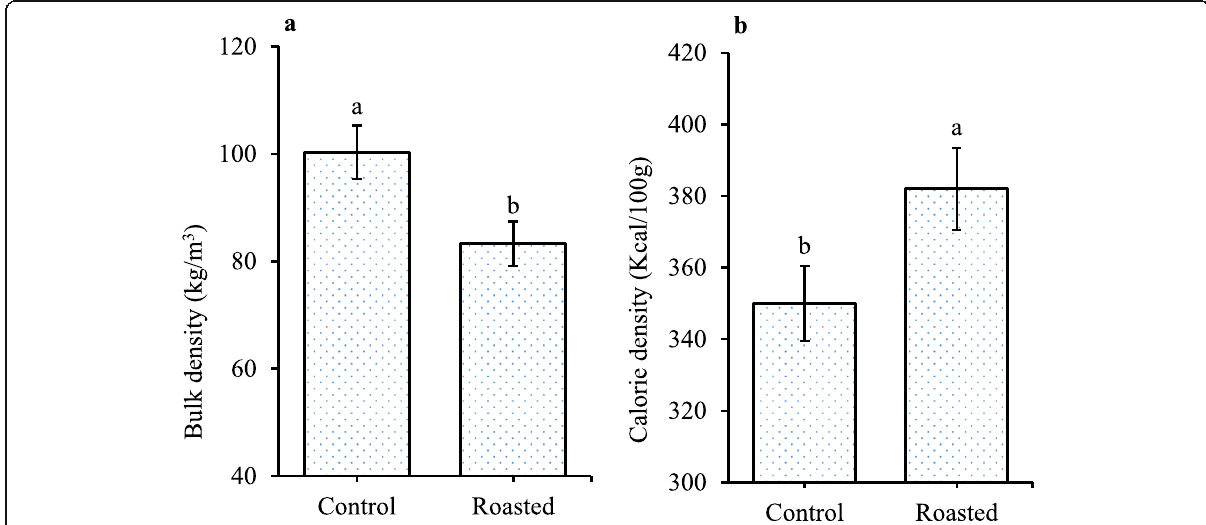
Fig. 4 Impact of roasting on a) Bulk density and b) Calorie density of fox nuts . Values are means of 3 replications; error bars stand for standard deviation. Means sharing different letters show significant difference between the variables based on Independent T-test at P ≤ 0.05